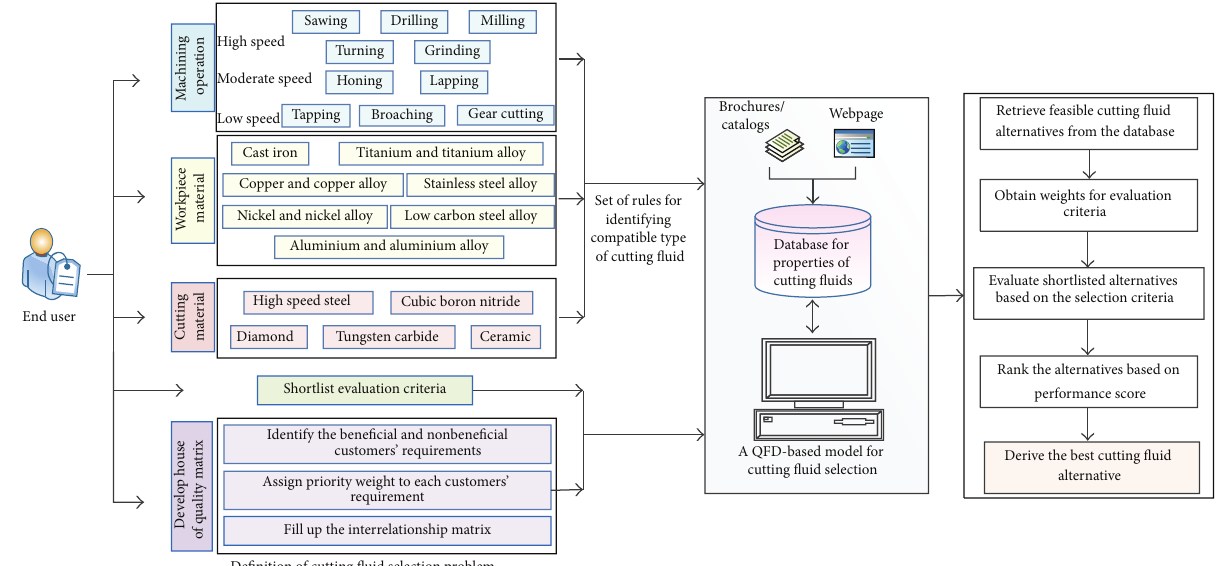
Figure 2: Architecture of the QFD-based model for cutting fluid